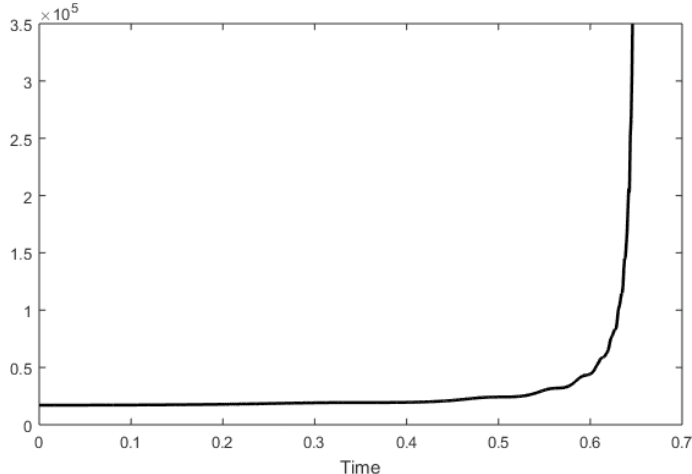
versus time for Z = L 2 rad